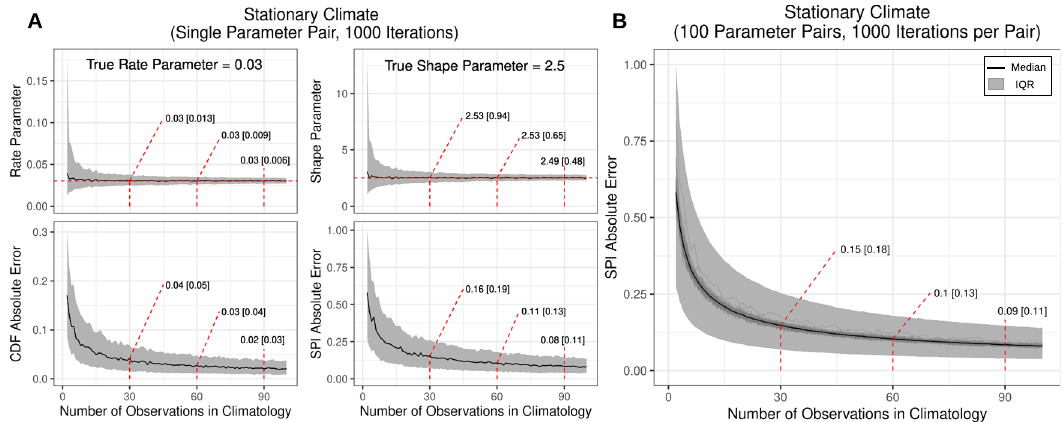
Fig. 3 Summary of simulations that fi t gamma probability distributions to a known stationary distribution. These simulations use random samples of varying climatology lengths (from 2 to 100) and the L-moment method for estimating gamma parameters. A Subplots showing the detailed simulation results for a single gamma distribution pair derived from 1000 simulations; rate and shape parameters as well as the cumulative distribution function (CDF) absolute error and Standardized Precipitation Index (SPI) absolute error are presented. Black lines and gray ribbons represent the median [interquartile] value of the 1000 simulations. B Replication of the aforementioned simulation for 100 randomly selected gamma distribution parameter pairs, each simulated 1000 times, focused on the absolute SPI error.